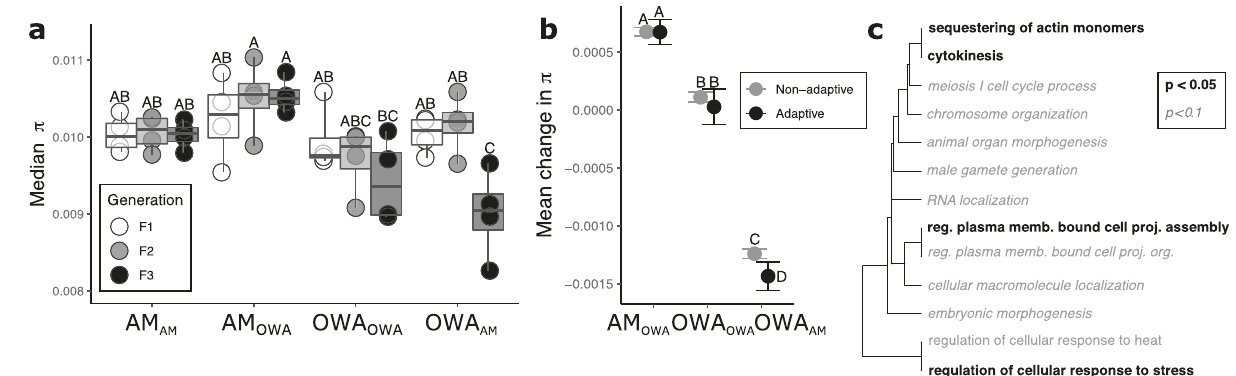
Fig. 5 Changes in genetic diversity. a Median nucleotide diversity ( π ) for all treatments and generations following transplant ( n = 4 biologically independent replicates per treatment and generation). Boxes represent the upper and lower 25% quantiles and median while whiskers are min and max. Letters above each point show signi fi cance from Tukey post hoc comparisons following an ANOVA where P < 0.05; b Mean change in π from after transplant for adaptive and non-adaptive SNPs with 95% con fi dence intervals ( n = 9177 π estimates per replicate). Changes relative to AM AM F1. Letters indicate signi fi cance from two-sided Wilcoxon tests with a Bonferroni correction and 0.05 signi fi cance threshold. c Gene ontology enrichment for the loss of genetic diversity of OWA AM at transplant F3; AM OWA showed no enrichment. Source data are provided as a Source Data fi le.